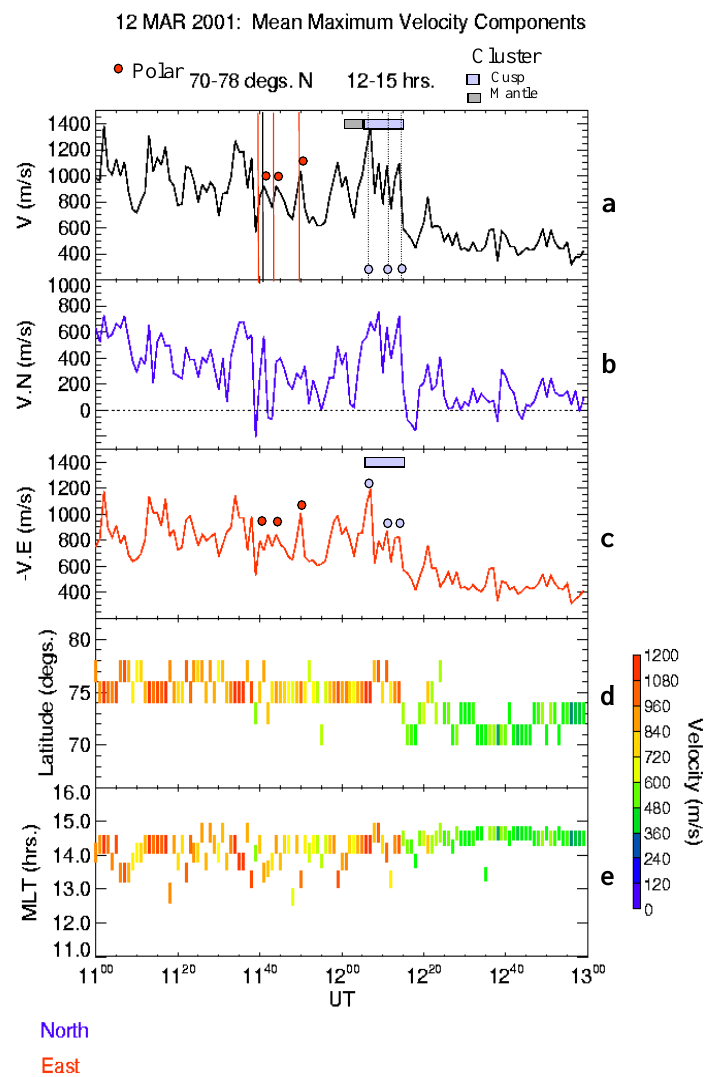
Fig. 17. The maximum velocities and their locations determined by Super- DARN for the interval between 11:00 and